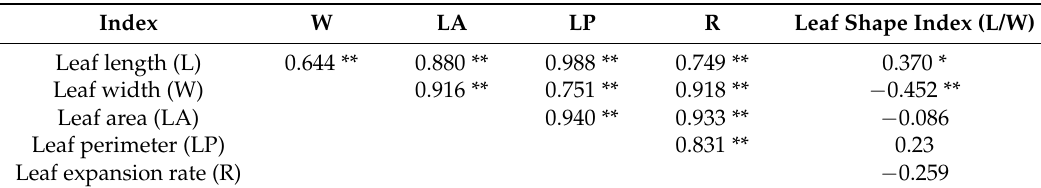
Table 3. Bivariate correlations of leaf length, width, area, perimeter, expansion rate and shape index (Pearson correlation coefficient).